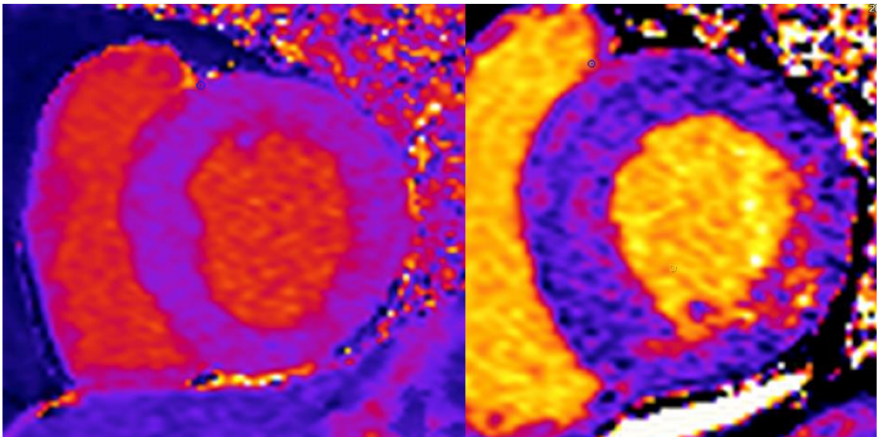
Figure 7. CMR T1 mapping at 2 disease stages in patients with FD. ( Left ) T1 map with reduced relaxation times representing early sphingolipid accumulation in a patient with Fabry and early cardiomyopathy; ( Right ) T1 map with “pseudonormalisation” of T1 representing fibrosis within the myocardium in a patient with advanced Fabry